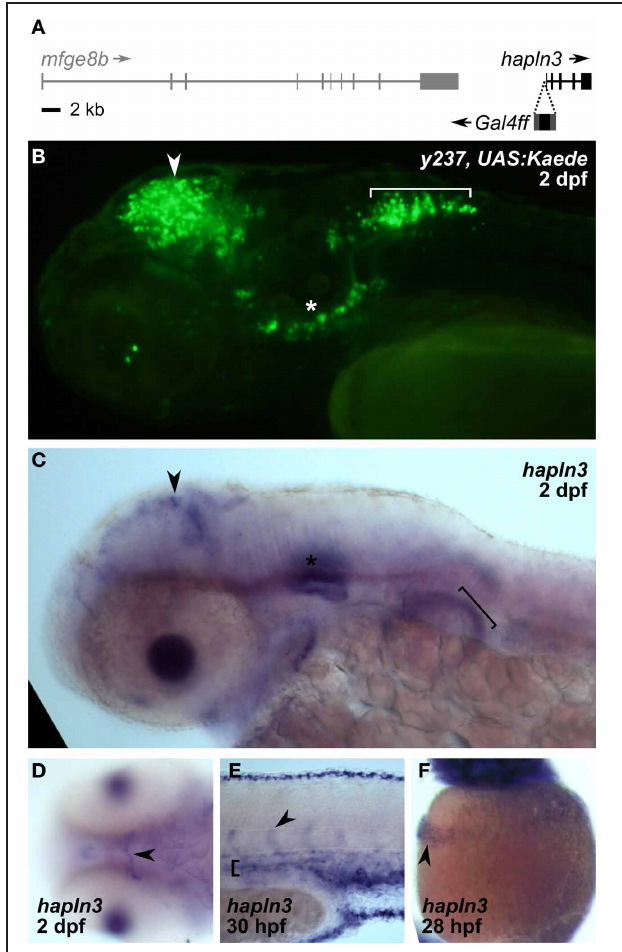
FIGURE 5 | REx2 enhancer trap y237 recapitulates tectal expression of the adjacent hapln3 gene. (A) The Gal4ff reporter in y237 is integrated on chromosome 3, between mfge8b and hapln3 , 190bp from the first exon of hapln3 . (B) y237 transgenic larvae show Kaede reporter expression in the optic tectum (arrowhead), adjacent to the otic vesicle (asterisk) and in the hindbrain (bracket). Lateral view, 2dpf. (C) WISH (2dpf) shows that hapln3 is expressed in the optic tectum (arrowhead), in the otic vesicle (asterisk) and non-neuronal tissues including pectoral fin (bracket). (D) Dorsal view of head (2dpf) reveals cranial vasculature expression of hapln3 , arrowhead shows basal communicating artery (Isogai et al., 2001). (E) Lateral view of tail (30hpf) shows expression of hapln3 in the dorsal aorta (bracket), the source of cells which form intersegmental vessels (arrowhead). (F) Lateral view of yolk (28hpf) showing hapln3 in hatching gland